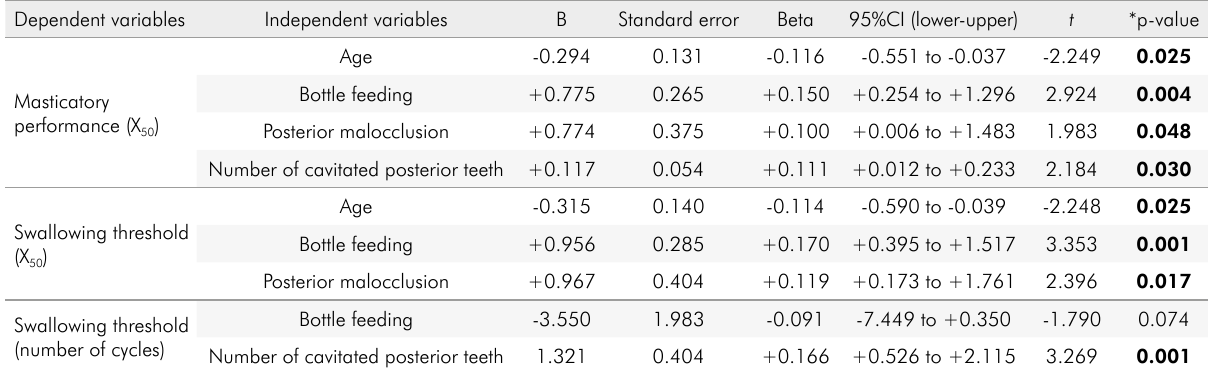
Table 3. Multiple linear regression using the test of association between independent variables and parameters for masticatory function (n = 384, Diamantina, Brazil) (backward